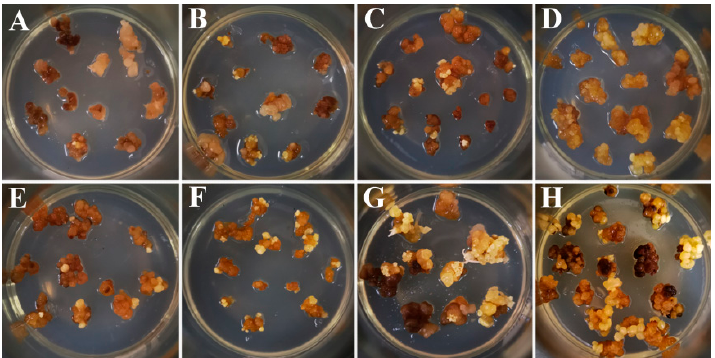
Figure 3. The growth of resistant calli at various pH of RC (re-suspension solution and co-cultivation medium). ( A – D ), resistant calli obtained in RC with pH 5.8. ( E – H ), resistant calli obtained in RC with